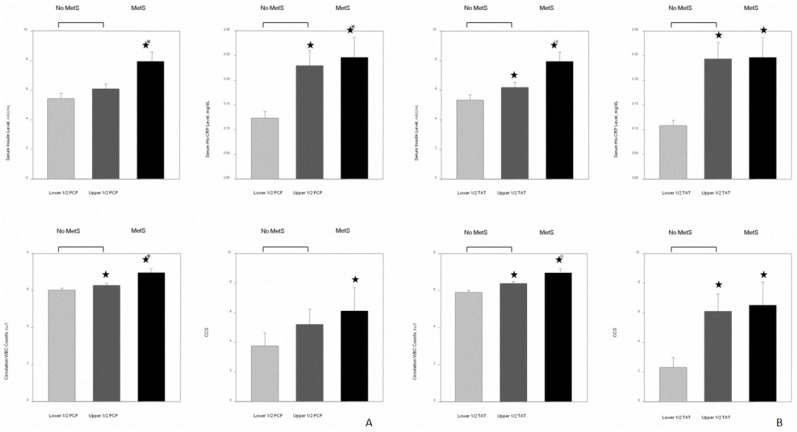
Comparison of serum insulin level, high sensitivity C-reactive protein (hs-CRP), circulating white blood cell (WBC) count and coronary calcium score (CCS) among subjects with and without metabolic syndrome.Those without metabolic syndrome are further divided into upper and lower halves of visceral adipose tissue volume. A) Pericardial adipose tissue (PCF); mean volumes in the three groups were 48.3±10.2, 86.9±23.3 and 86.4±25.6 ml, respectively. B) Thoracic peri-aortic adipose tissue (TAT); mean volumes in the three groups were 3.8±1.1, 8.4±2.7 and 9.4±3.3 ml, respectively. ★p<0.05 vs lower visceral adipose tissue volume without metabolic syndrome, ★p<0.05 vs upper visceral adipose tissue volume without metabolic syndrome (Kruskal-Wallis test with post hoc paired comparison).